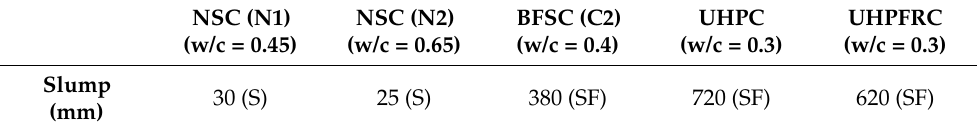
Table 4. Workability of concrete